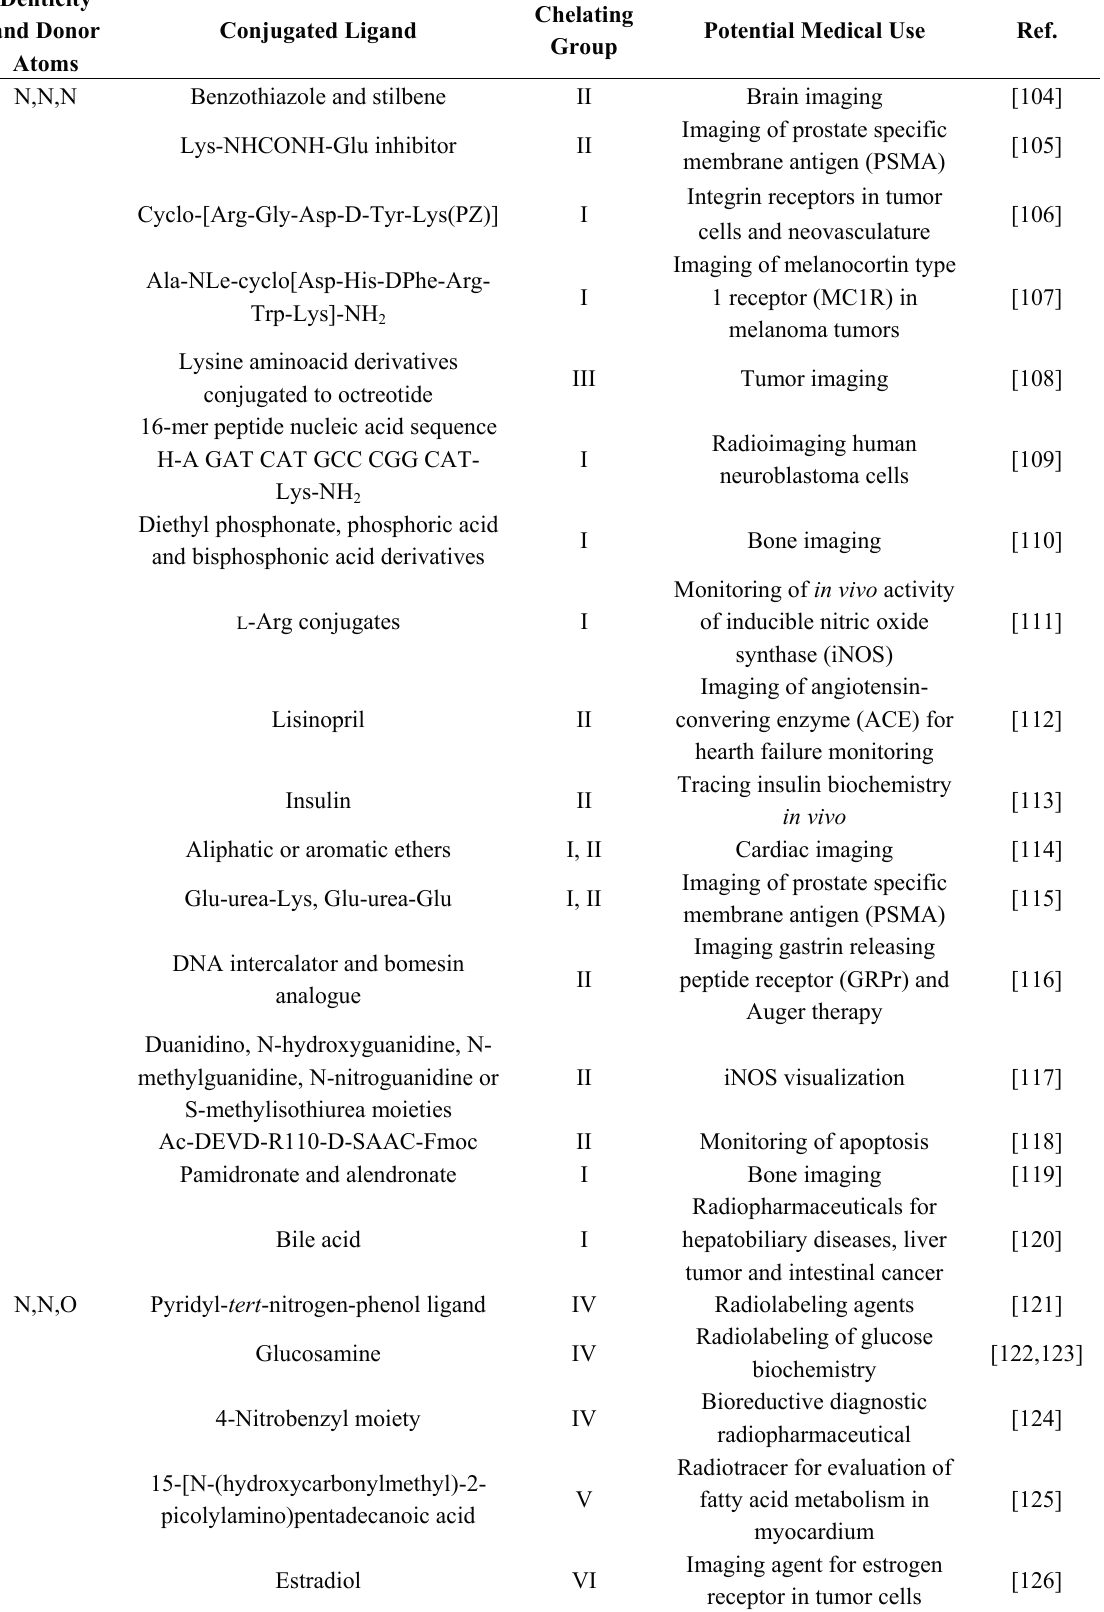
Table 1. Synthesis of 99m Tc complexes with chelating tridentate N containing ligands.